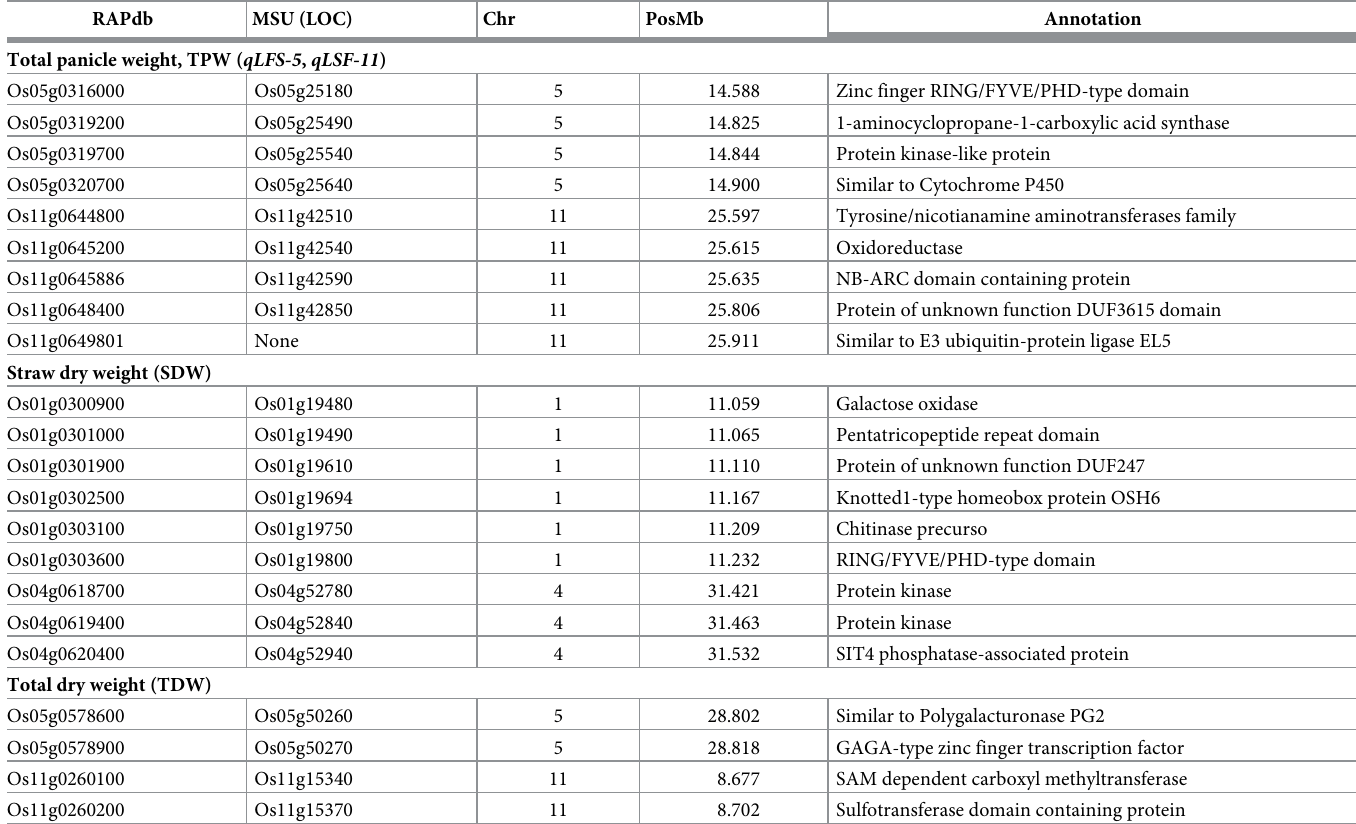
Table 3. List of potential candidate genes in QTLs associated to total panicle weight (TPW), shoot dry weight (SDW) and total dry weight (TDW). RAPdb MSU (LOC) Chr PosMb